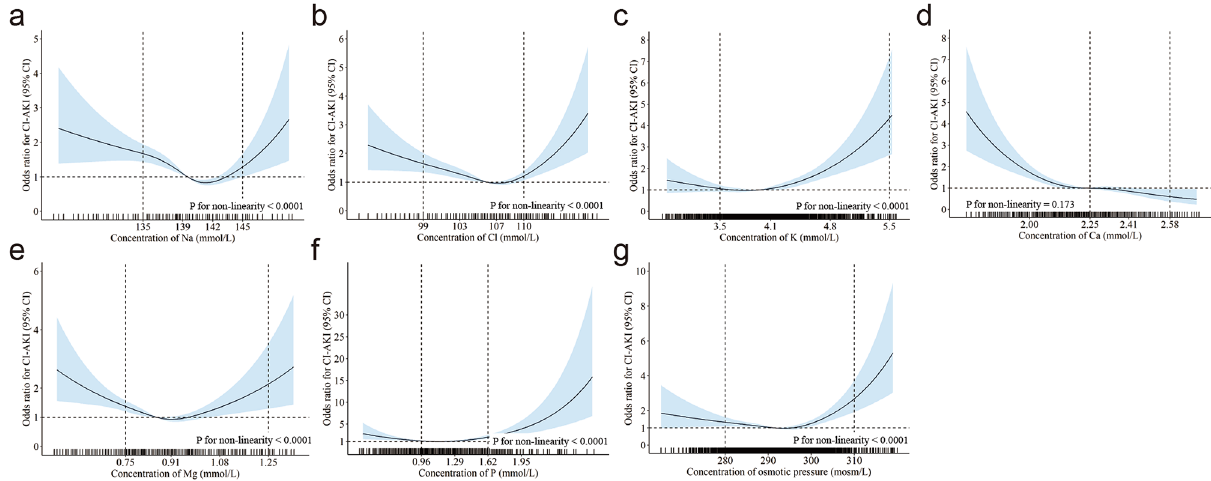
Figure 4. Piecewise linear curve fitting by restricted cubic spline models for the association of sodium ( a ), chloride ( b ), potassium ( c ), calcium ( d ), magnesium ( e ), phosphate ( f ), and osmotic pressure ( g ) distributions with CA-AKI incidence. Models adjusted for age(< 65 or ≥ 65 years) and eGFR (< 30, 30–59, 60–89, or ≥ 90 mL/ min/1.73 m 2 ), gender (male or female), diabetes (yes or no), hypertension (yes or no), current smoker (yes or no), current drinker (yes or no), type of contrast agent (ioversol, iopamidol, or iodixanol), pre-admission of furosemide injection (yes or no), pre-admission of dopamine (yes or no). Odds ratios are indicated by solid lines and 95% confidence intervals by shaded areas. The lowest value of CA-AKI incidence was selected as the reference point for sodium, chloride, potassium, magnesium, phosphate, osmotic pressure. The third category was selected as the reference point for